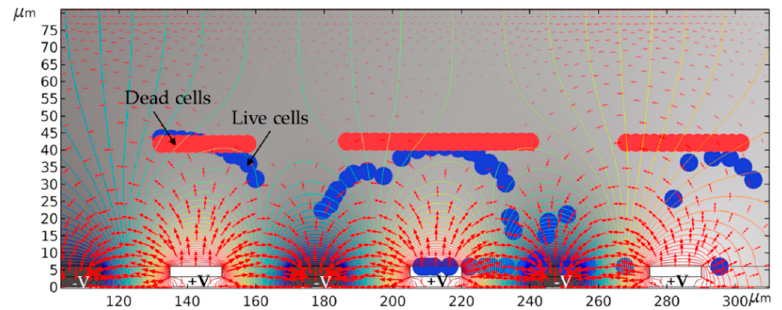
Figure 4. FEM simulation results for cell separation. DEP generated by IDEs, shown in black and white segments (marked by − V and +V, respectively). The line contour illustrates the electric potential applied to the IDEs, and red arrows represent the electric field distribution.